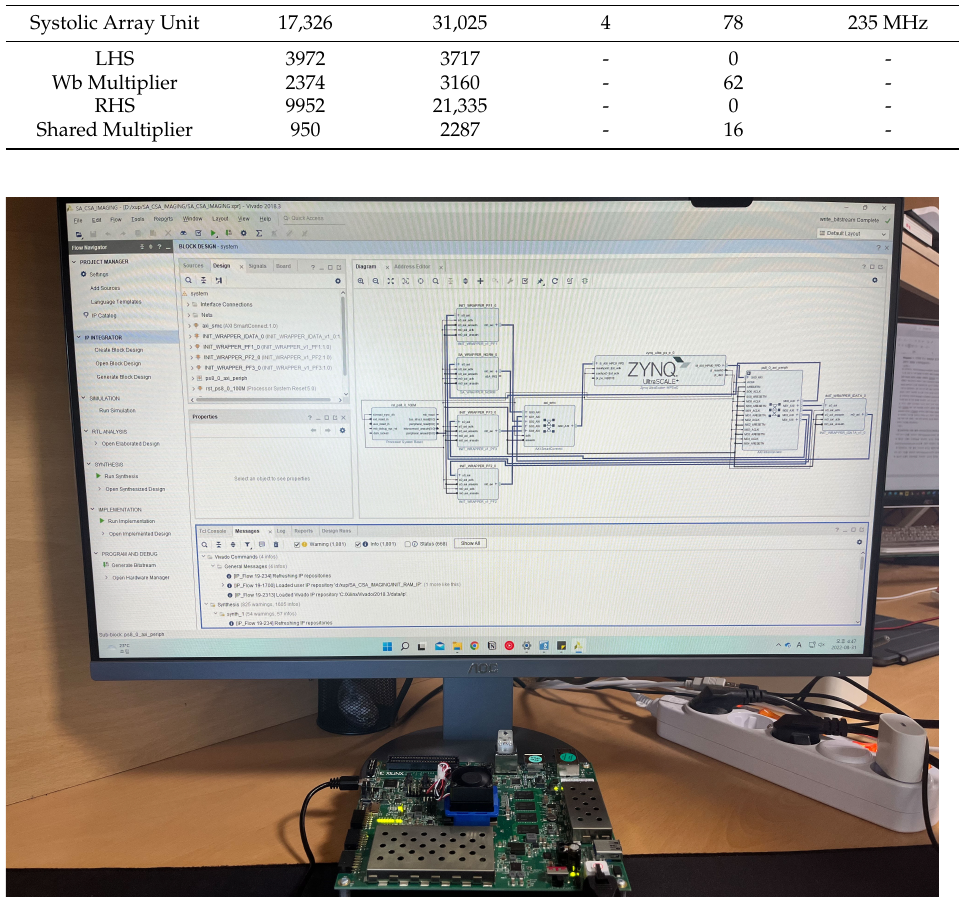
Figure 9. Verification environment for the proposed FPGA